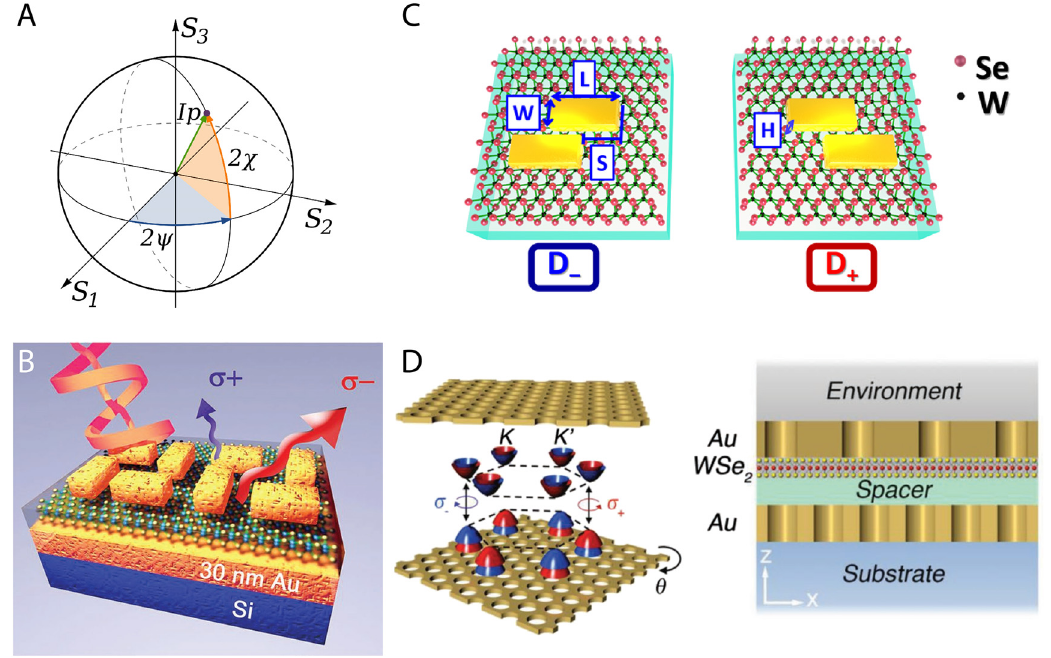
Figure 4: Controlment of the valley-selective circular dichroism using chiral metamaterials. (A) The Poincar ´ e sphere, the parametrization of the S1, S2, and S3 in spherical coordinates. (B) The metal-dielectric-metal plasmonic